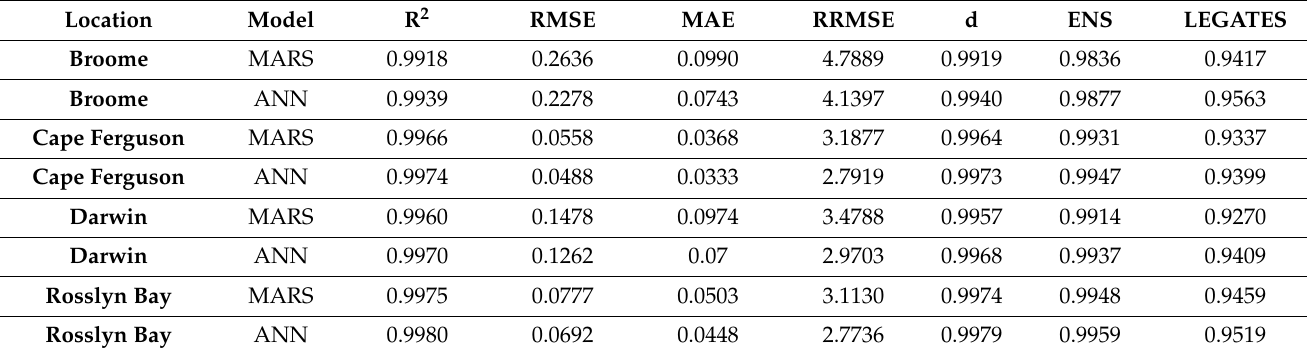
Table 6. Testing metrics for both models at all